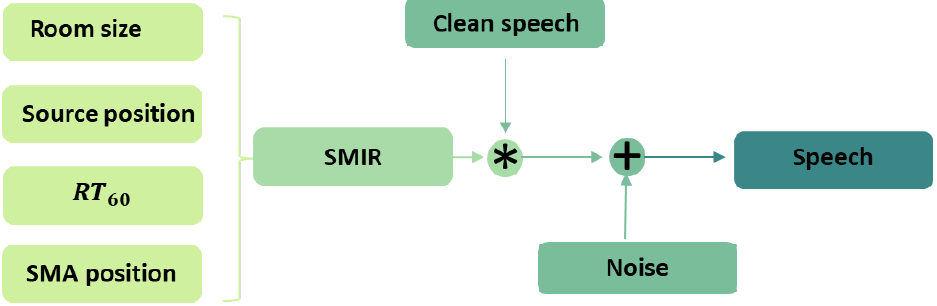
Figure 6. The process for obtaining the speech with position information and reverberation.